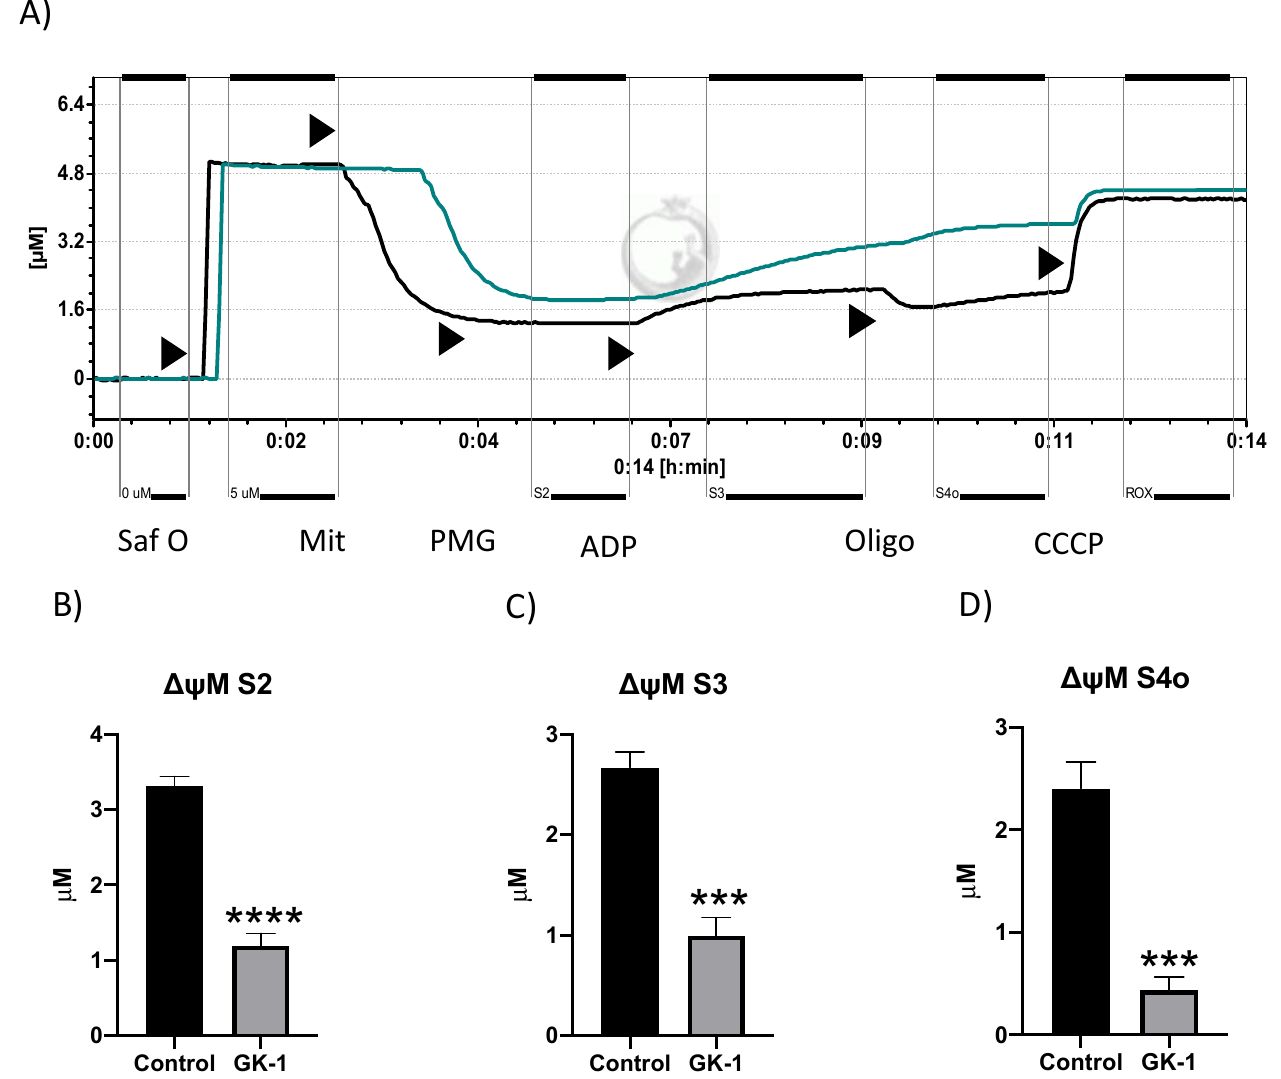
Figure 8. GK-1 dissipates mitochondrial membrane potential ( ΔΨ m) in mouse breast tumors. ( A ) Representative tracings of mitochondrial membrane potential evaluation using complex I (CI)-associated substrates comparing experimental groups control vs. GK-1. We added the different substrates to the O2k FluoRespirometer chamber in the following sequence: Safranine (Saf O), mitochondria (Mit), pyruvate–malate–glutamate (PMG), adenosine phosphate (ADP), oligomycin (Oligo), and carbonyl cyanide 3-chlorophenylhydrazone (CCCP). ( B ) Membrane potential in state 2 (S2), ( C ) membrane potential associated in state 3 (S3), and ( D ) membrane potential in state 4 induced by oligomycin (S4o). The potential in state 2 is obtained with the addition of the sample plus the substrates. t -student test, control vs GK-1, *** p < 0.0005 and **** p < 0.00005. Data are expressed as mean ± SEM, n = 5. The green line indicates solution saline isotonic treatment (control), and the black line indicates GK-1 treatment. The addition of the different substrates is indicated by